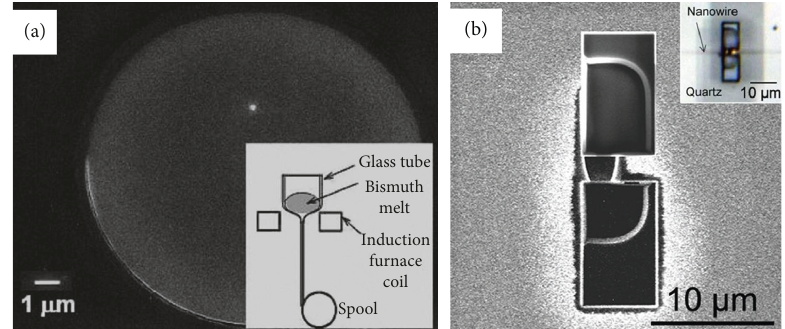
Figure 4: (a) Cross-sectional SEM image of a Bi nanowire grown by (a) the Ulitovsky method (the inset diagram outlines the growth mechanism) [70] and (b) pressurized injection in a quartz template [80]. Rreprinted with permission from [69] American Physical Society and [79] ©